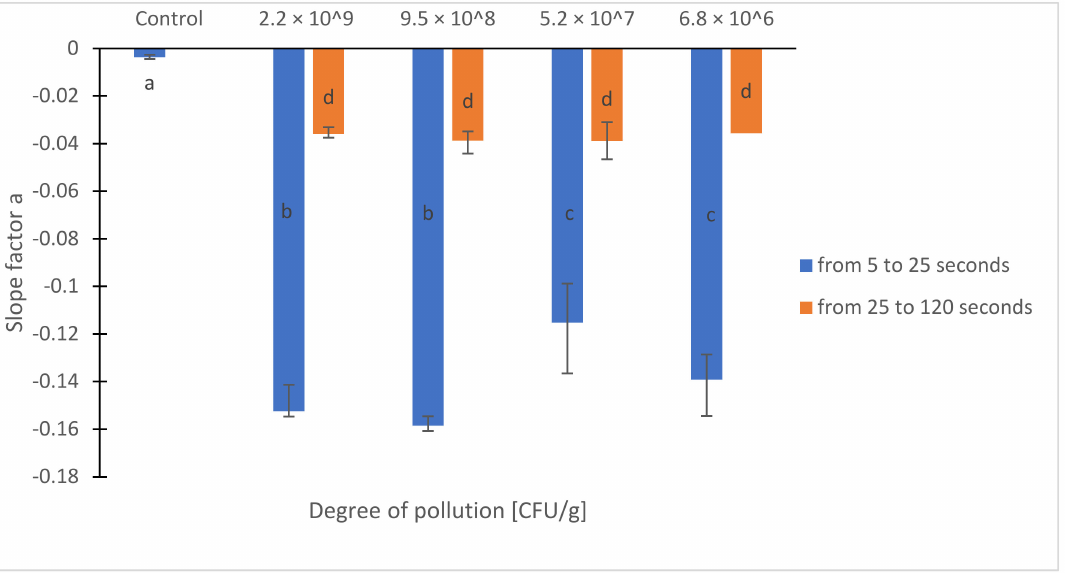
Figure 3. Comparison of temperature regression coefficients (mean values and standard deviation) relative to the time after the activation of B. subtilis bacteria contamination samples: 2.2 × 10 9 CFU/g, 9.5 × 10 8 CFU/g, 5.2 × 10 7 CFU/g, and 6.8 × 10 6 CFU/g; a–d—different letters on the bars indicate statistically significant differences between the samples by Tukey’s test ( p <